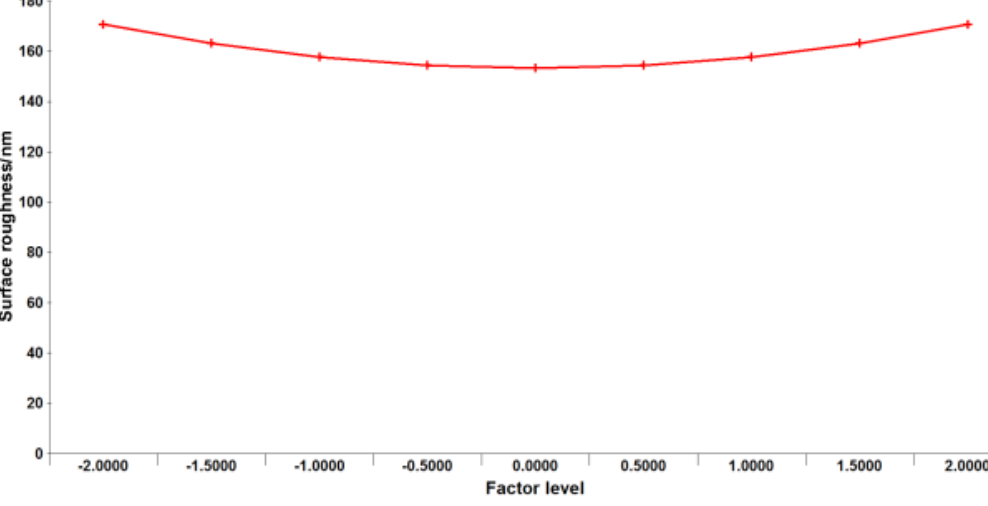
Figure 11: The effect of electrolysis current on surface roughness